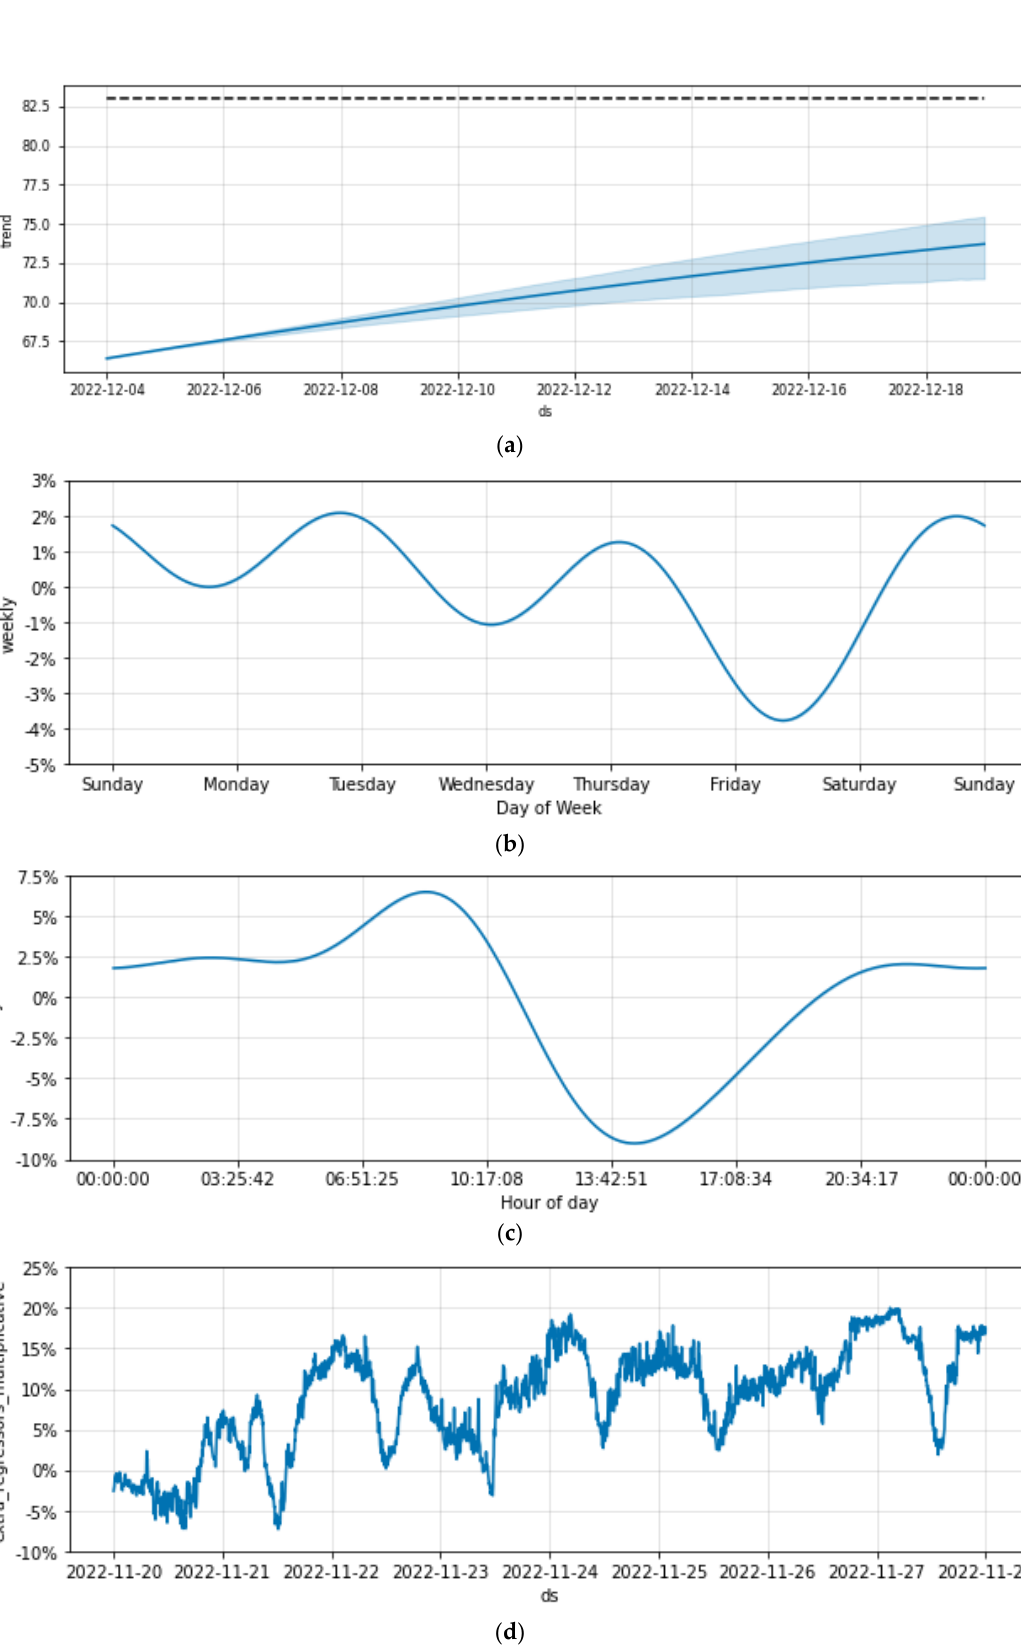
Figure 17. Decomposing the time series in trend ( a ) and cyclicity factors ( b , c ). Practically, no weekly trend is detected in ( b ), and a daily strong cyclicity of humidity detected between day and night hours in ( c ). In ( d ) the role of extra regressors is